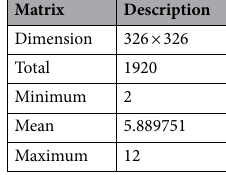
Table 6. Summary of spatial-weighting object,